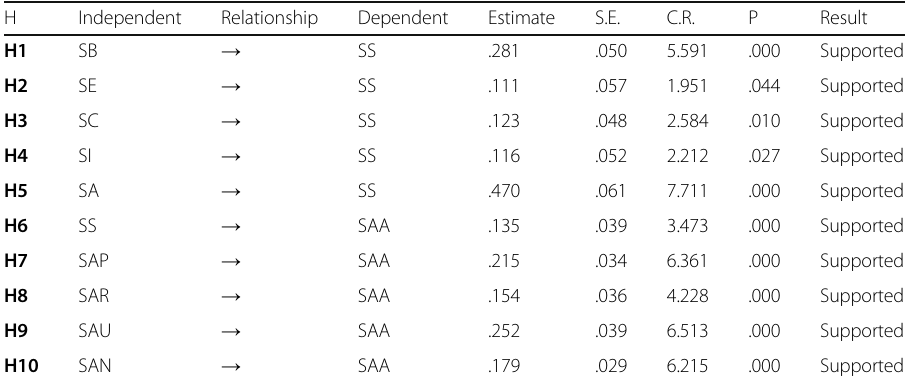
Table 3 Testing Results of the